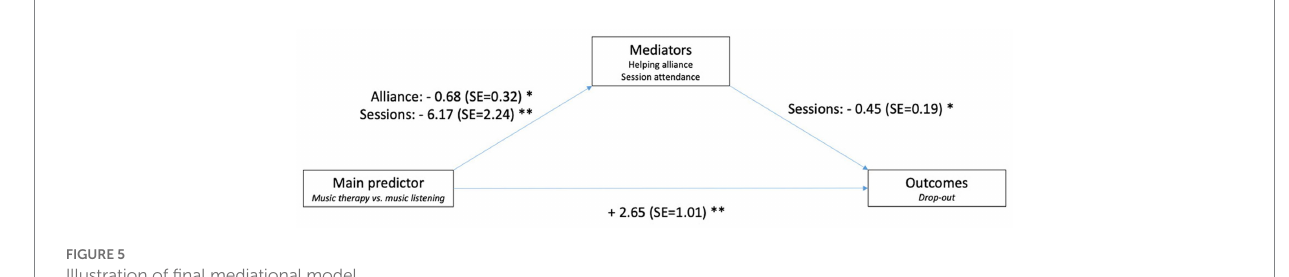
FIGURE 5 Illustration of final mediational